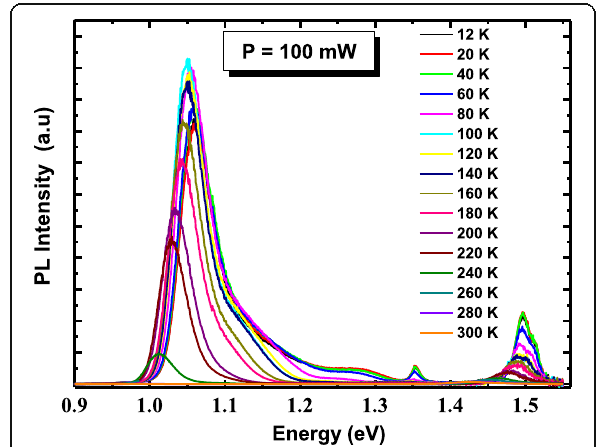
Fig. 6 Temperature-dependent PL spectra from the InAs/InGaAs QD heterostructure measured at an excitation power of 100 mW